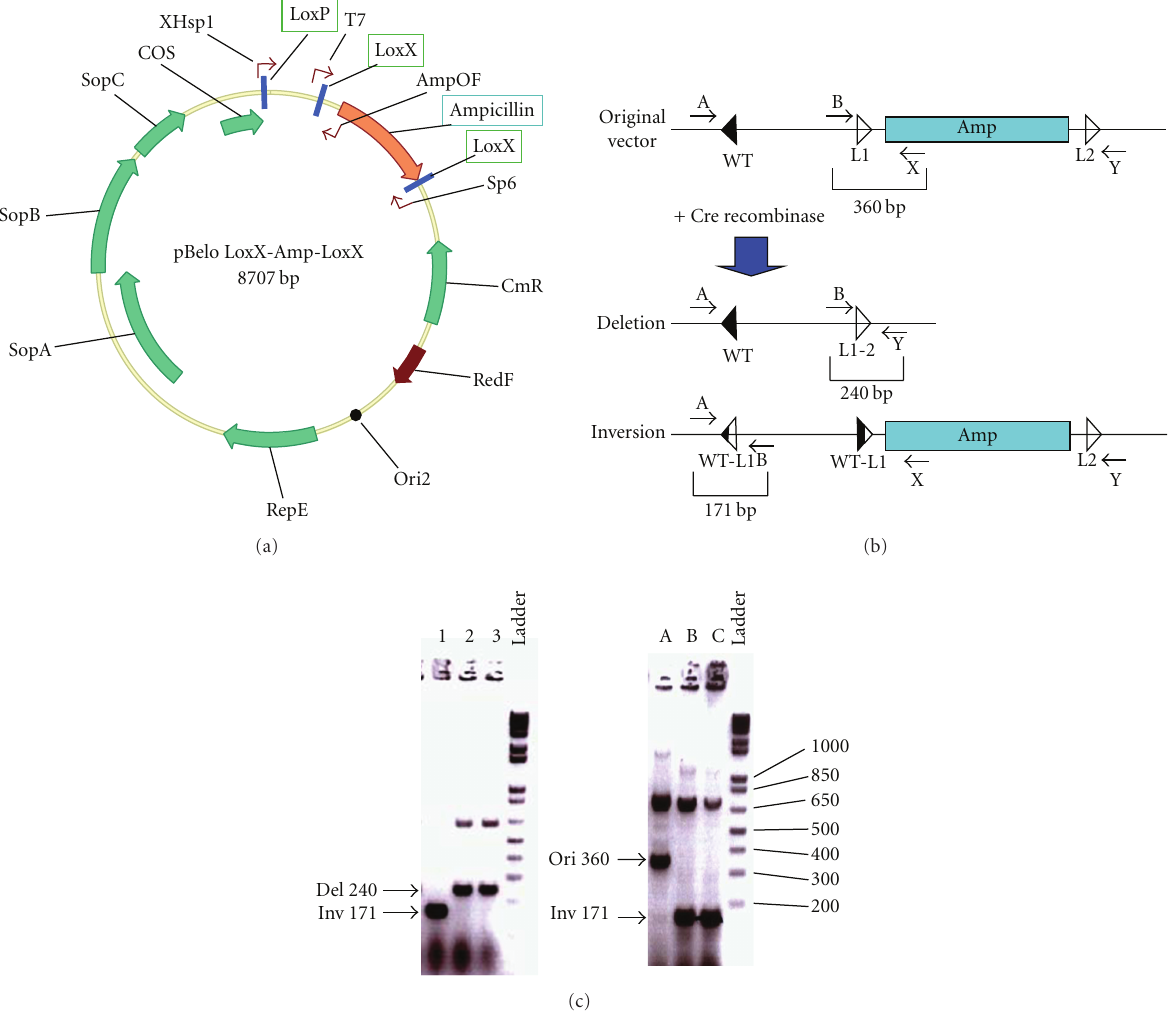
Figure 5: Specificity of Lox variant site reactions. (a) Vector map of Lox-flanked selection cassettes in a single-copy BAC backbone. Lox site locations indicated in green boxes and Ampicillin cassette indicated in teal box. (b) At top, organization of Lox sites and selection cassette in vector prior to Cre expression. Below are listed the expected products following Cre expression. Primer locations are indicated by arrows. In PCR analyses, the original cassette produces a 360bp band, while the Cre-mediated products of deletion or inversion produce bands of 240 bp and 171bp, respectively. (c) Gel electrophoresis of colony PCR analysis of EL350 bacterial bearing the BAC testing vector after induction of Cre expression and plating. PCR-positive bands indicate when a deletion or inversion has taken place (lanes 1, 2, and 3, (left)). PCR-positive bands indicate when unmodified clones and clones with an inversion are present (lanes A, B, and C, (right)). One Kb Plus DNA ladder (Ladder) is displayed at the right of each gel photograph. The molecular weight of relevant bands is indicated next to the gel on the